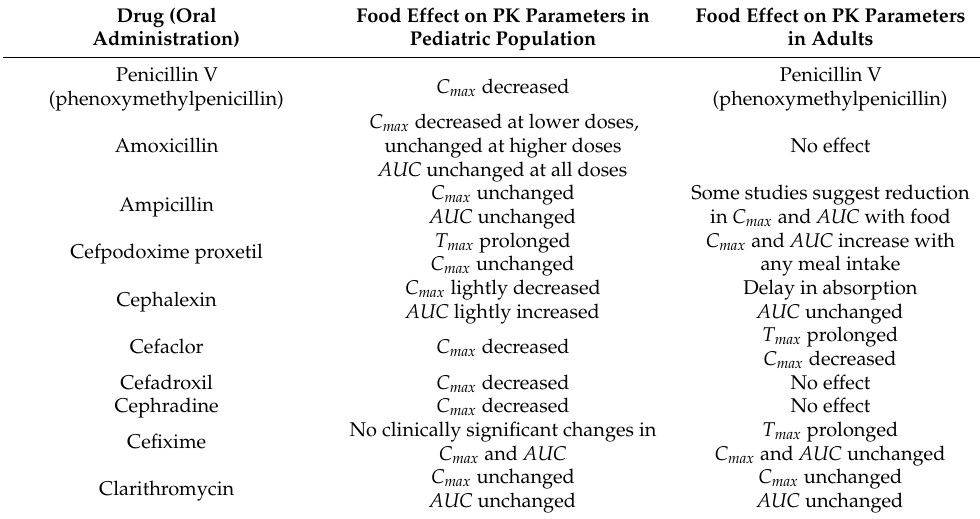
Table 3. Food effects on absorption of oral antibiotics in pediatric and adult populations.